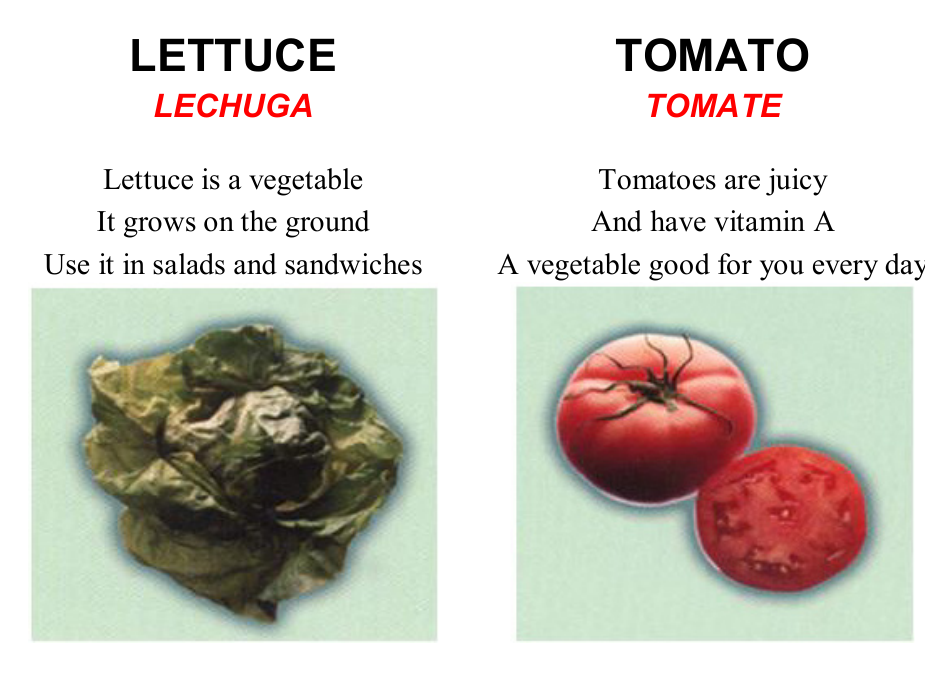
Figure 2. Game cards: pictures and